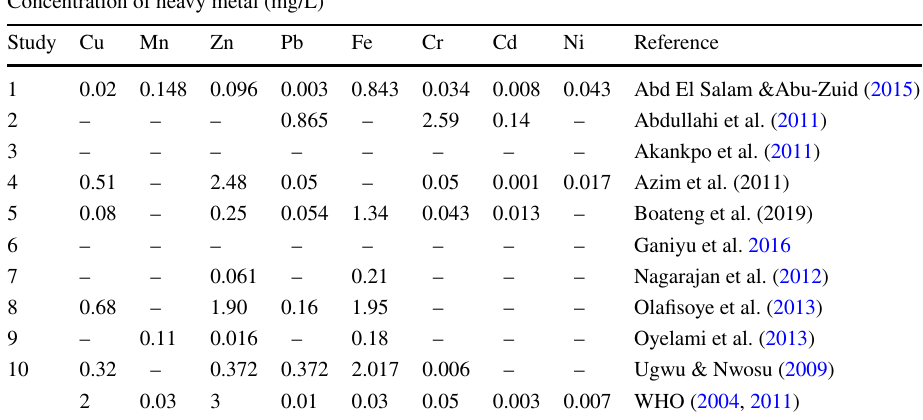
Concentration of heavy metal